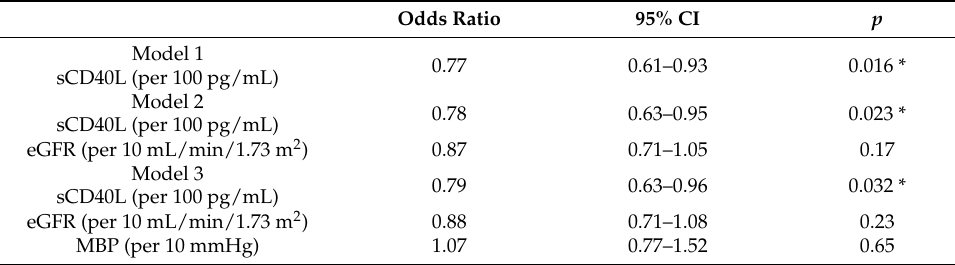
Table 3. Multivariate odds ratios for proteinuria ( ≥ 1.0 g/gCr) in different models including serum sCD40L in IgAN.